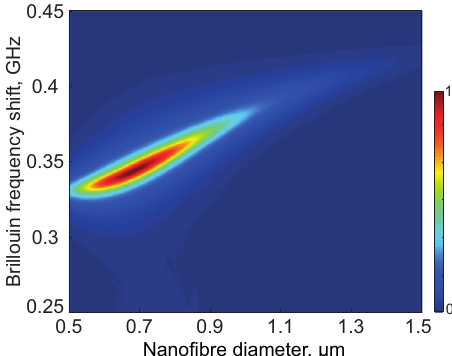
Fig. 2 Numerical calculation of the Brillouin spectrum. 3D calculation of normalised Brillouin scattering spectra in silica nano fi bres surrounded by 40 bar CO 2 for a diameter ranging from 500 nm to 1.5 μ